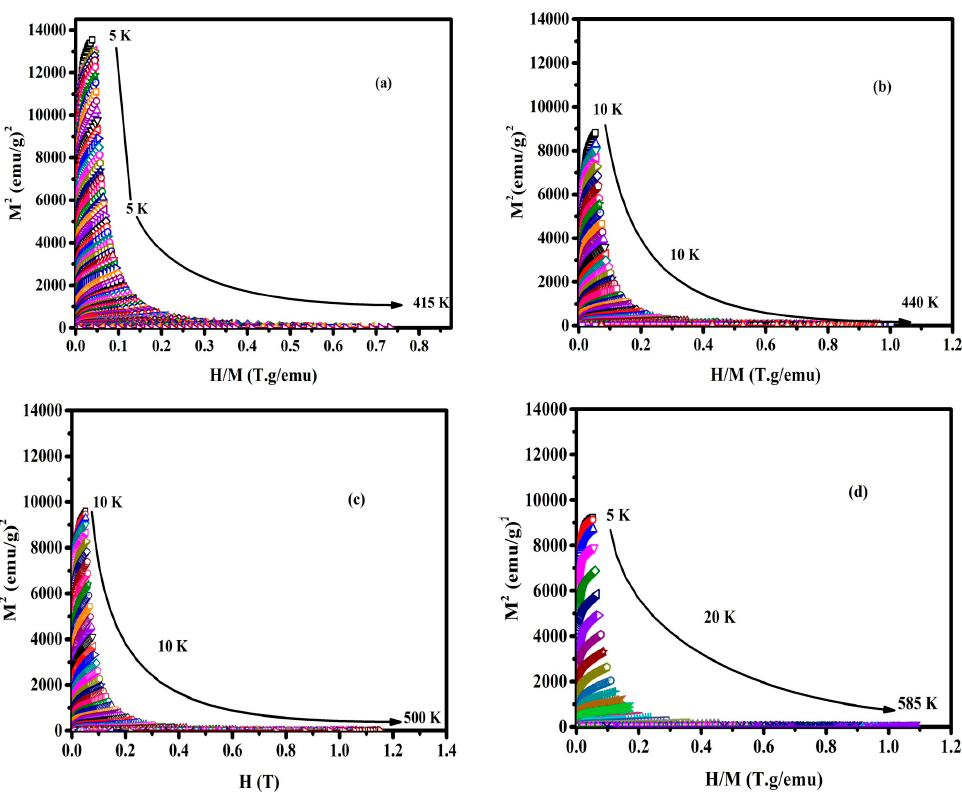
Figure 6. M 2 vs. µ 0 H / M isotherm traces plotted apart from Curie temperature for ( a ) Er(Fe 0.2 Mn 0.8 ) 2 , ( b ) Er(Fe 0.8 Mn 0.1 Co 0.1 ) 2 , ( c ) Er(Fe 0.7 Mn 0.2 Co 0.1 ) 2 , and ( d ) Er(Fe 0.7 Mn 0.1 Co 0.2 ) 2 .